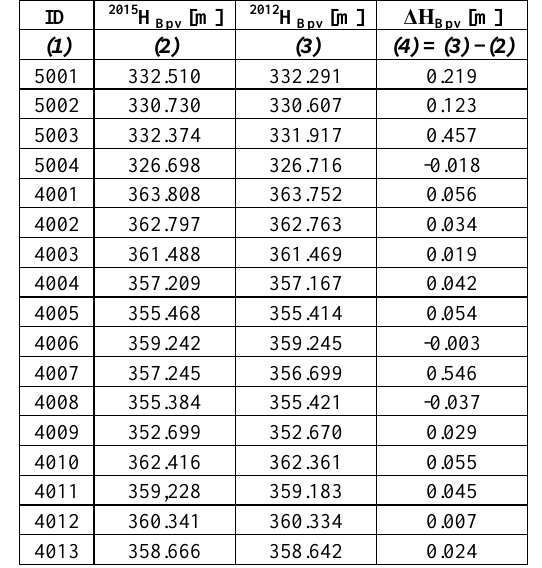
Table 6. Comparison of the elevations in survey net